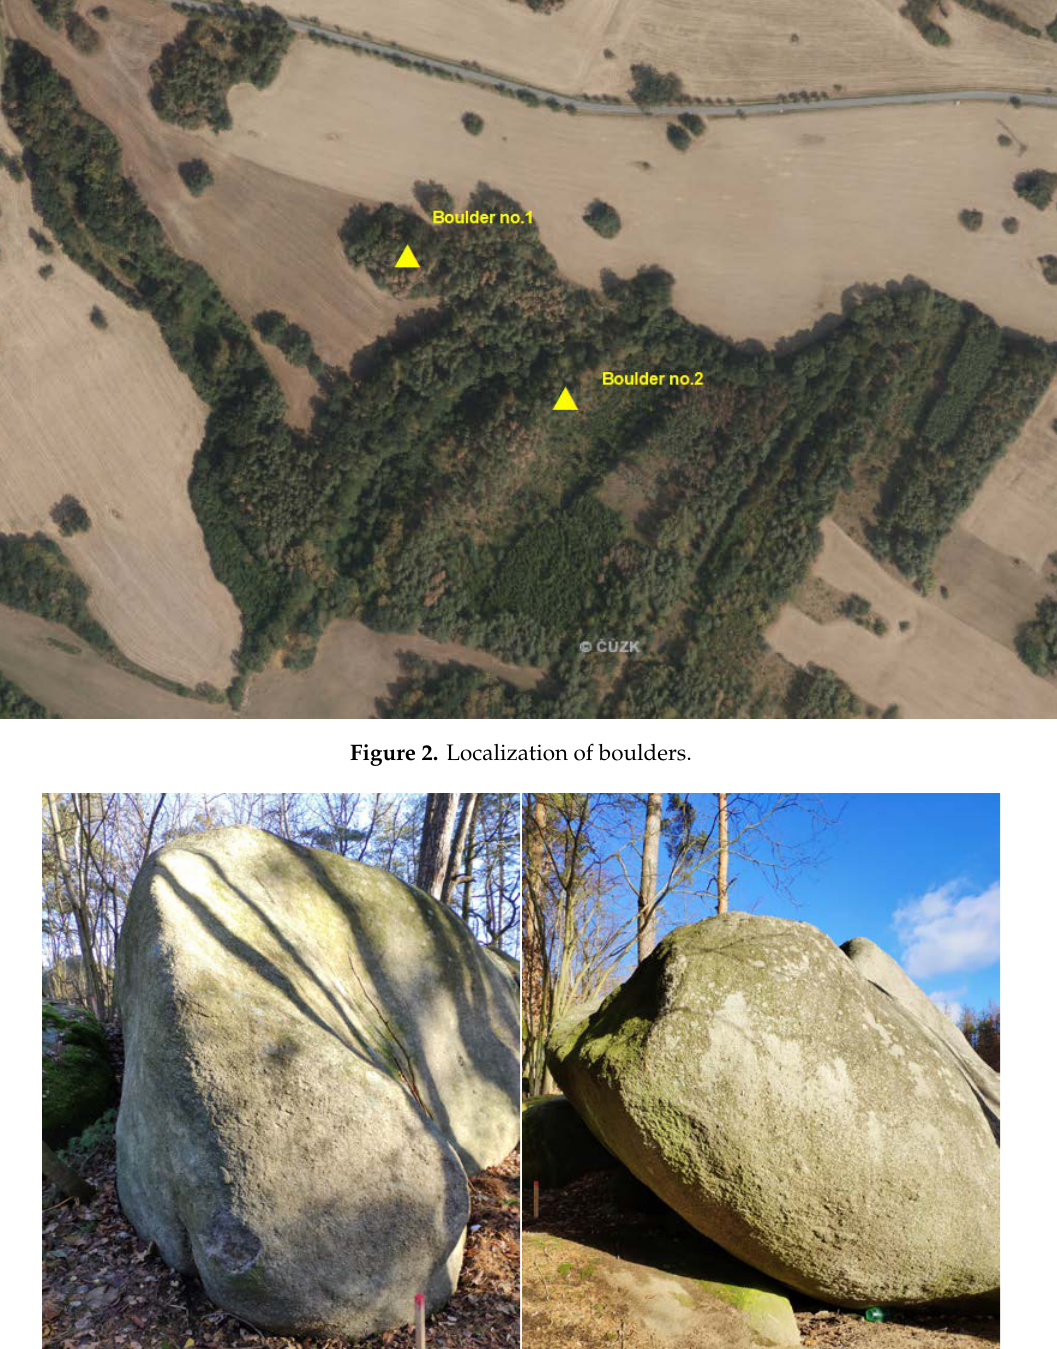
Figure 1. Location of Přečkov within the Czech Republic.